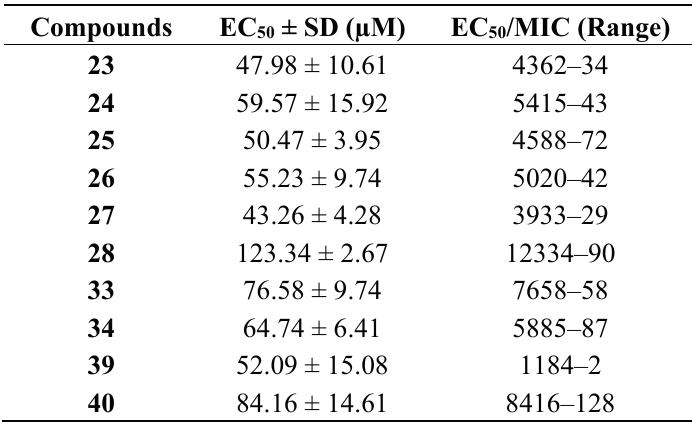
Table 3. Toxic effects of the selected triazole-CPX hybrids towards human HEK-293